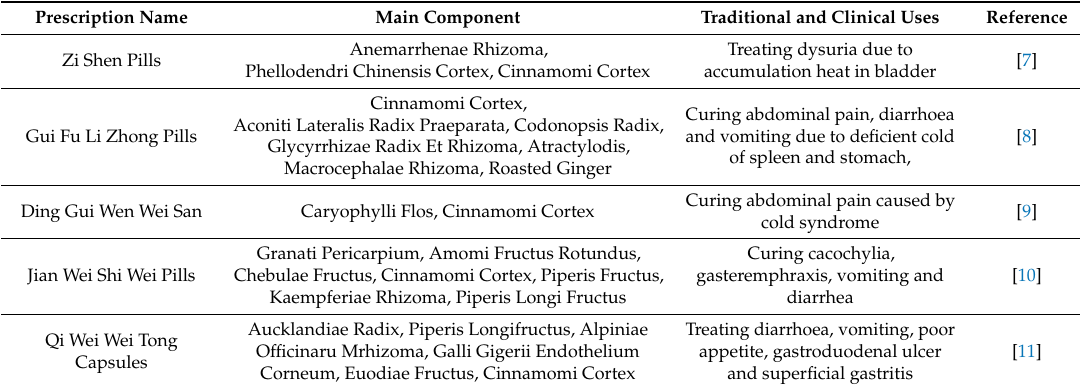
Table 1. The traditional and clinical uses of C. cassia in China.